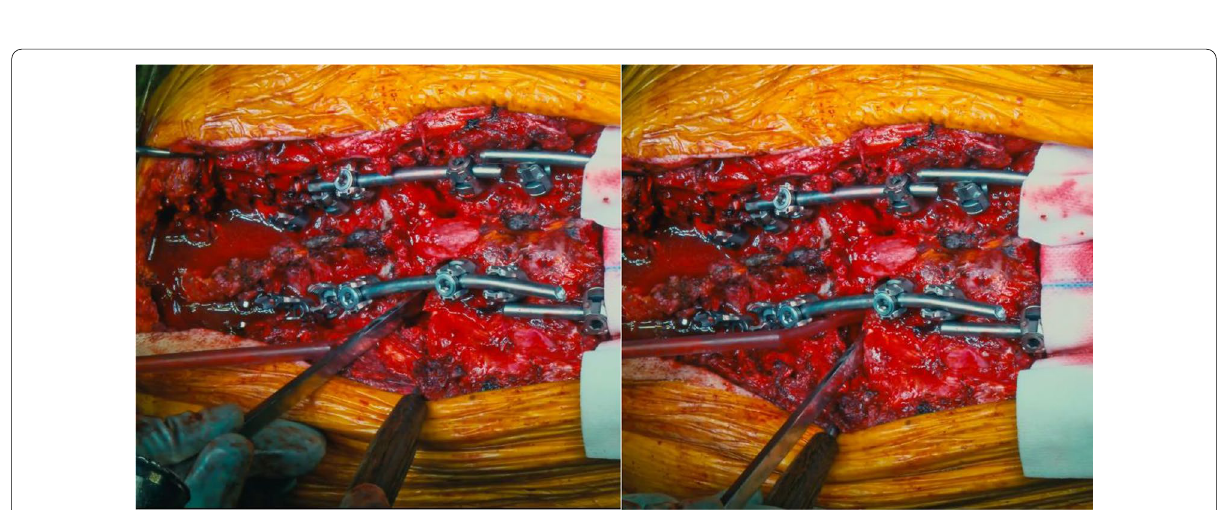
Fig. 6 The second PSO is performed at